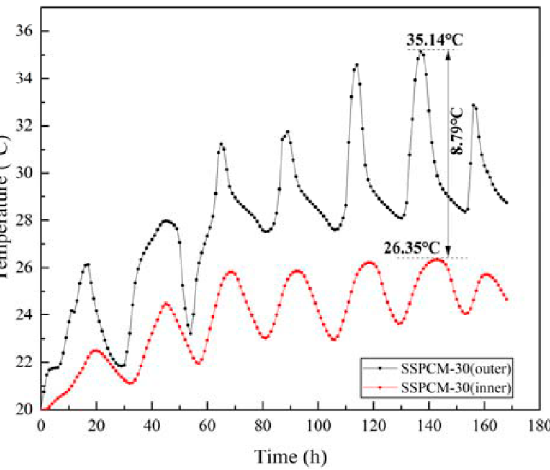
Figure 14. The internal surface temperature of the SSPCM layer at different SSPCM locations.